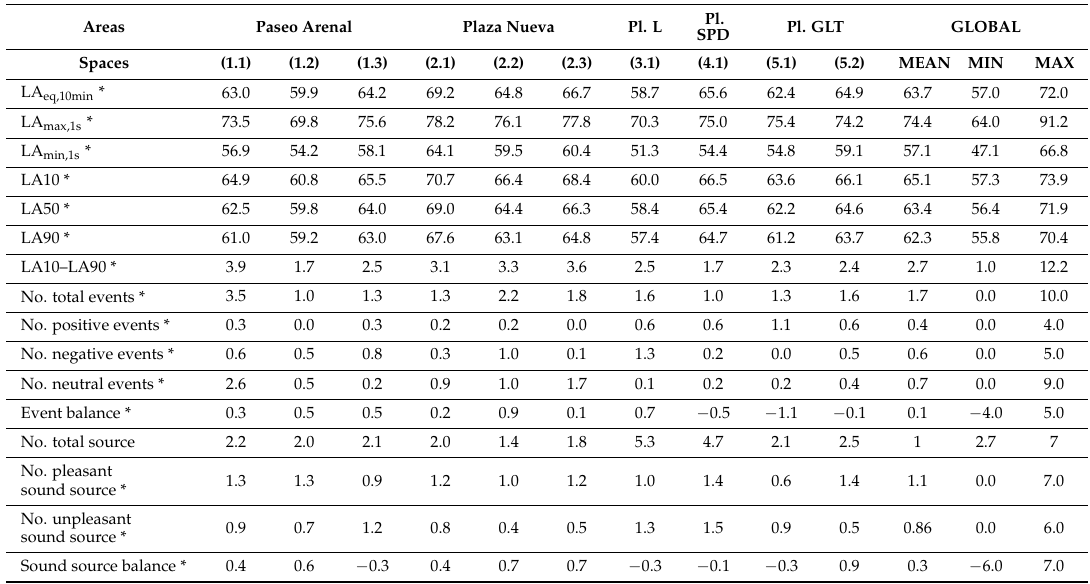
Table 3. Compared arithmetic means of acoustic variables according to the areas analysed (ANOVA analysis: * significant differences p <